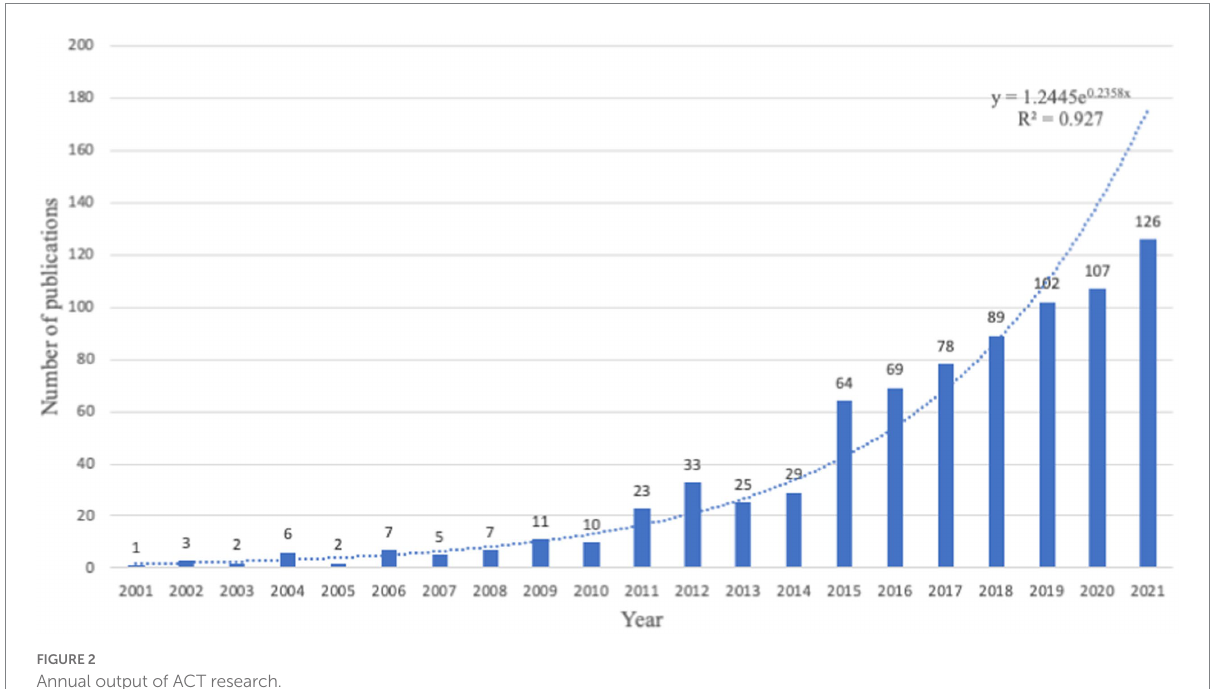
FIGURE 2 Annual output of ACT